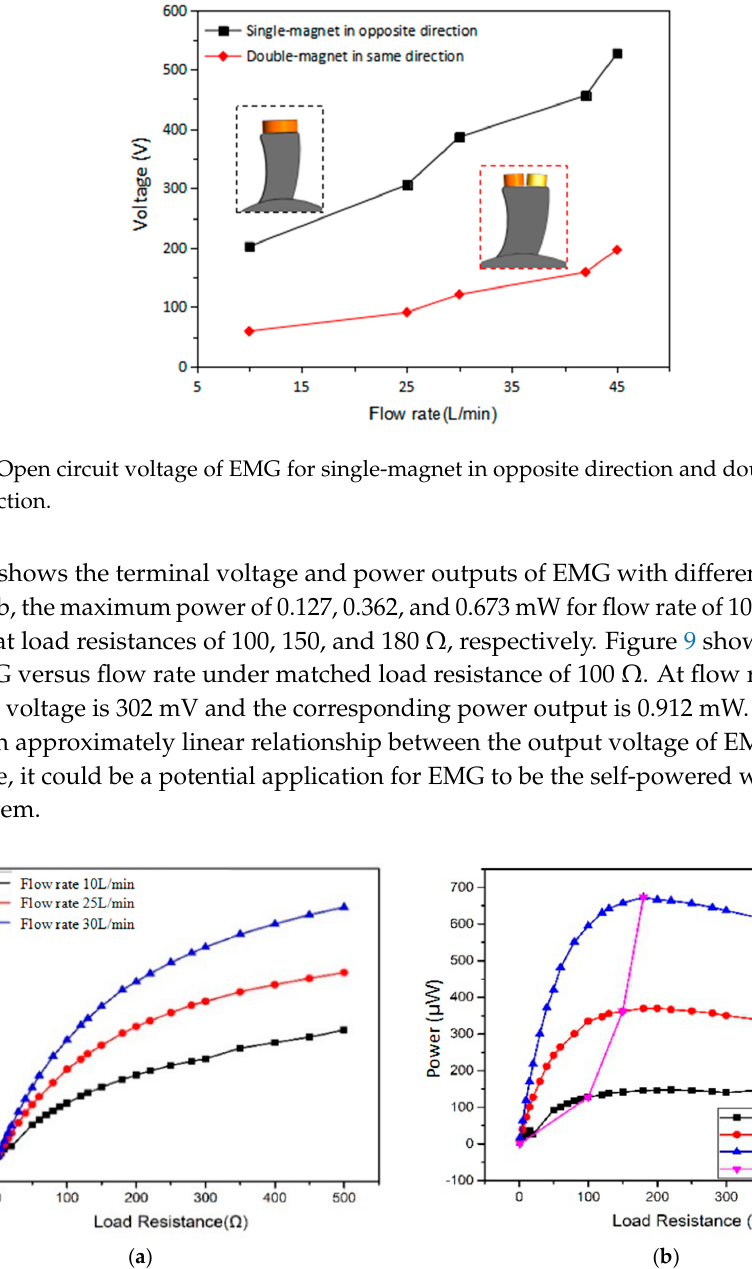
Figure 8. ( a ) Voltage and ( b ) power of EMG with different load resistances.